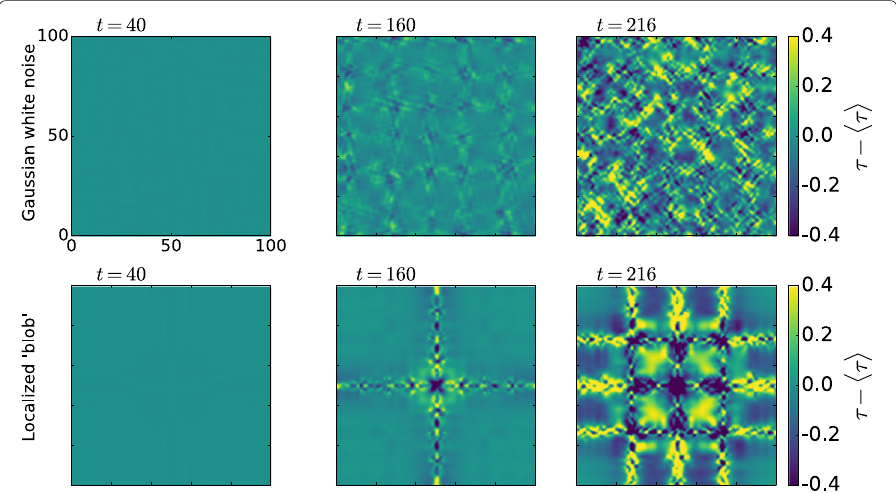
patterns are formed and ultimately drops to zero. For patterns emerging from a local- ized perturbation, there is an additional complication since the correlation oscillates as walls are formed sequentially. Either way, in the fully developed pattern there is no appre-